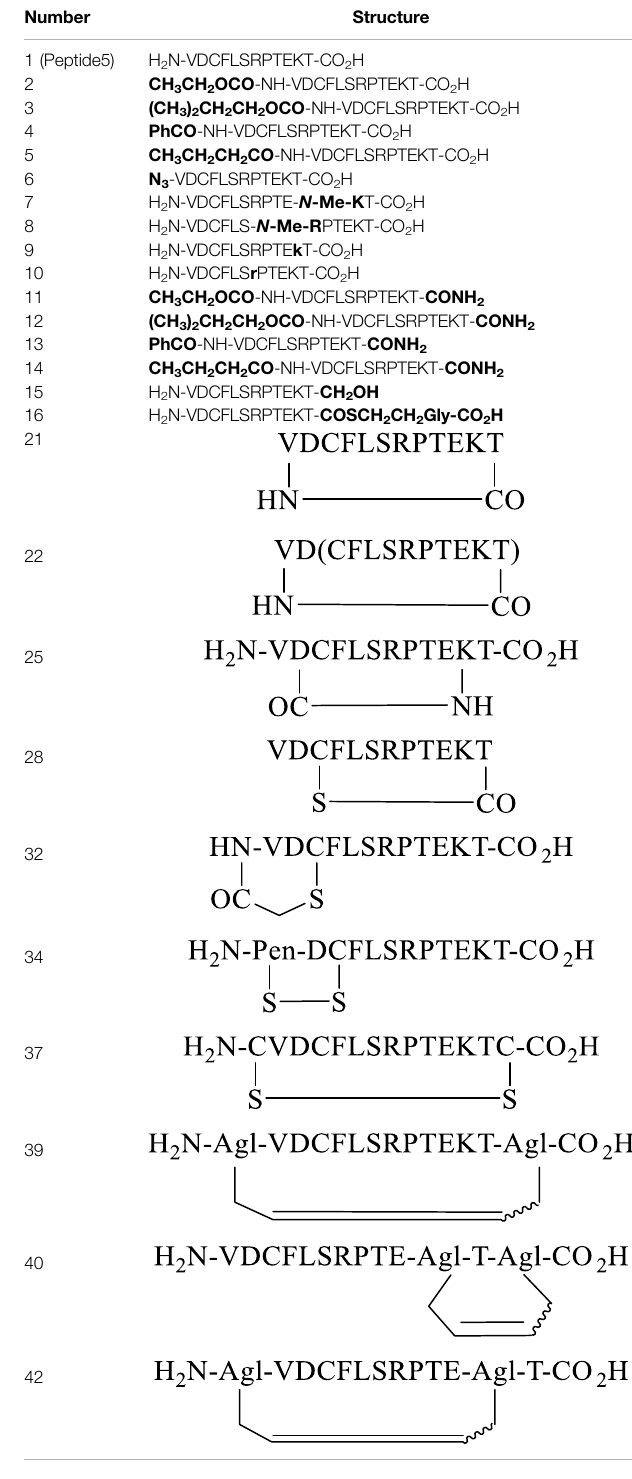
TABLE 1 | A summary of all linear and cyclic variants of the connexon43 inhibitor peptide. Peptide5 prepared. The chemical changes are highlighted in